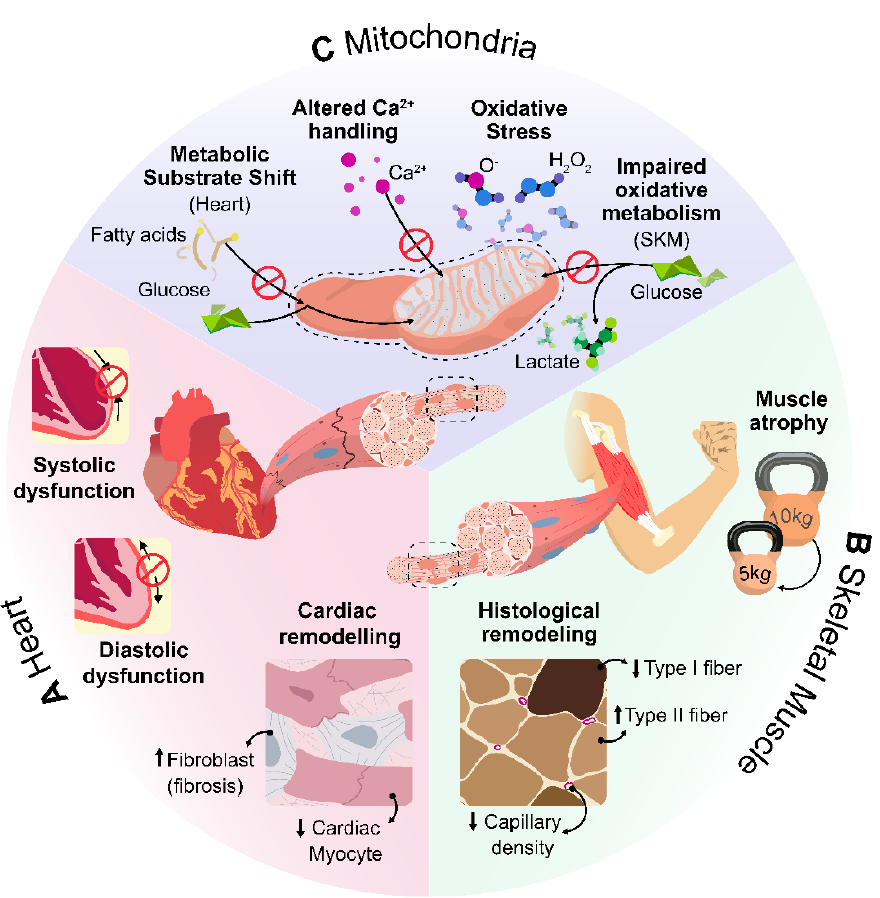
Figure 1. Pathophysiological mechanisms underlying exercise intolerance and their interactions in HF. In the multifactorial origin of heart failure, pathophysiological changes in several organ systems contribute to the development of signs and symptoms. Exercise tolerance in HF is influenced by changes in: ( A ) impaired cardiovascular performance, including systolic dysfunction, diastolic dysfunction, and remodeling of the cardiac tissue; ( B ) changes in skeletal muscle, including histological remodeling of skeletal muscle and a reduction in skeletal muscle mass and strength; and ( C ) metabolic and mitochondrial changes , including mitochondrial dysfunction, impairment of mitochondrial calcium handling, an increase in oxidative stress, and impaired oxidative skeletal muscle metabolism.